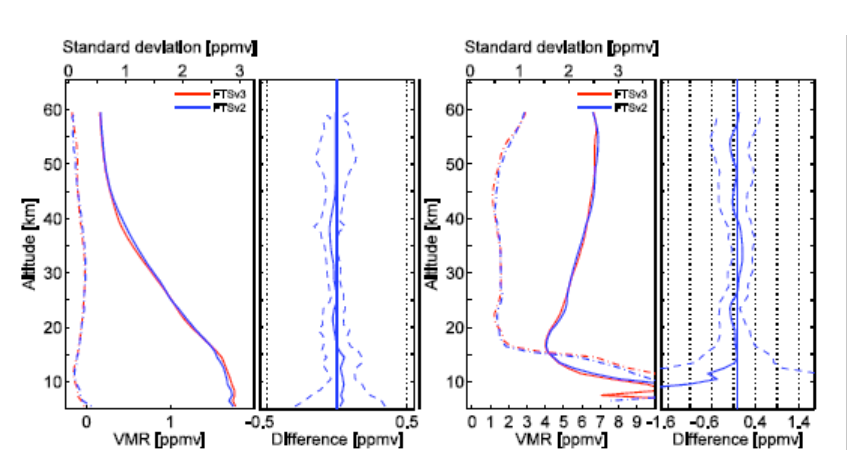
Figure 2: Two further examples of version 2.2 versus version 3.0 comparisons (mean profiles and absolute differences) for CH (left panels) and H O (right panels). The legend for each pair of panels is the same as given for the 4 2 corresponding panel in Fig. 1. Measurements from all latitudes are included in these comparisons.